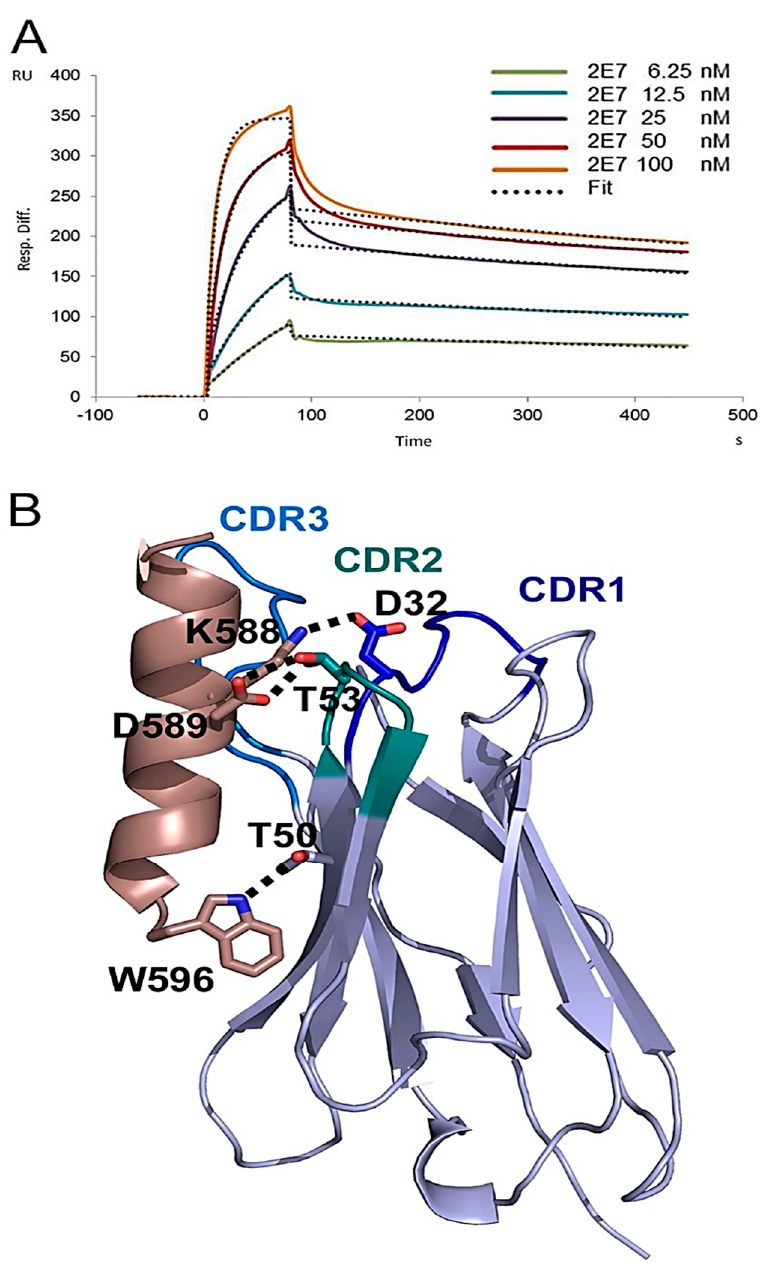
Figure 5. Structural analysis of 2E7 in complex with its gp41 HR1 epitope. ( A ) SPR analysis of VHH 2E7 with gp41int. 2E7 concentrations ranging from 6.25 to 100 nM were tested for binding to gp41int. Kinetic constants were derived by global fitting the data corresponding to the five indicated concentrations to a 1:1 Langmuir model (dotted lines) using local Rmax parameters. ( B )Ribbon diagram of the crystal structure of the 2E7 VHH in complex with a gp41 HR1 peptide. The gp41 peptide is shown in wheat and the VHH CDR regions are indicated by different colors. Polar interactions are shown as dashed lines.